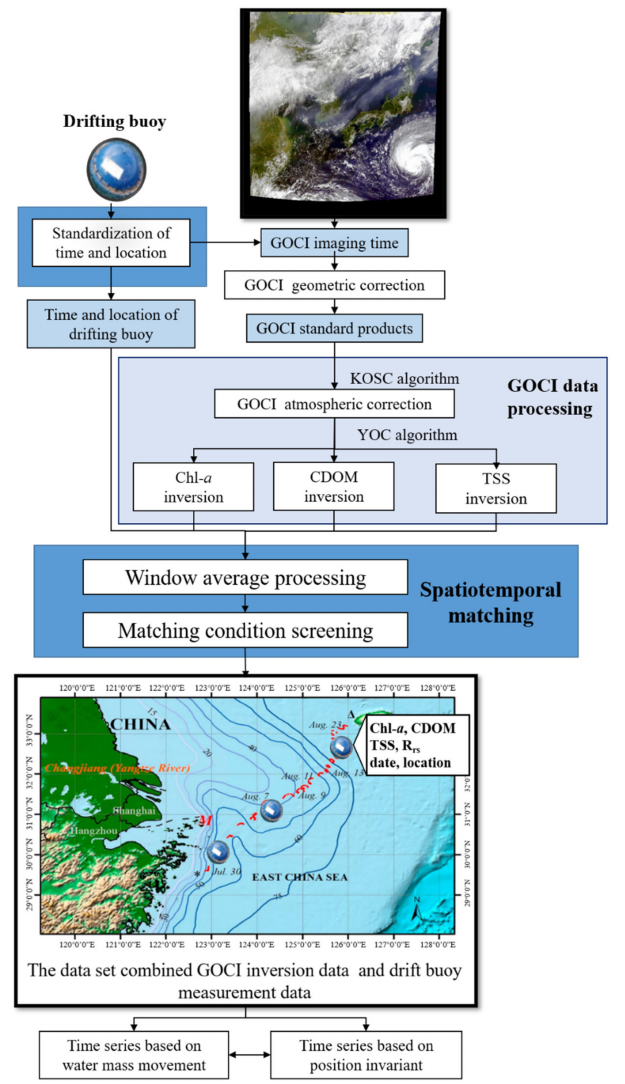
Figure 1. Diagram illustrating the proposed method. In the workflow of data processing, the trajectory of a drifter buoy is calculated and matched with GOCI data first. Then, the bio-optical properties obtained from matched pixel of GOCI products, including Chl a , ag 440 , and TSS, are added to expand the measurements of the buoy data that contain the longitude and latitude information as well as sampling